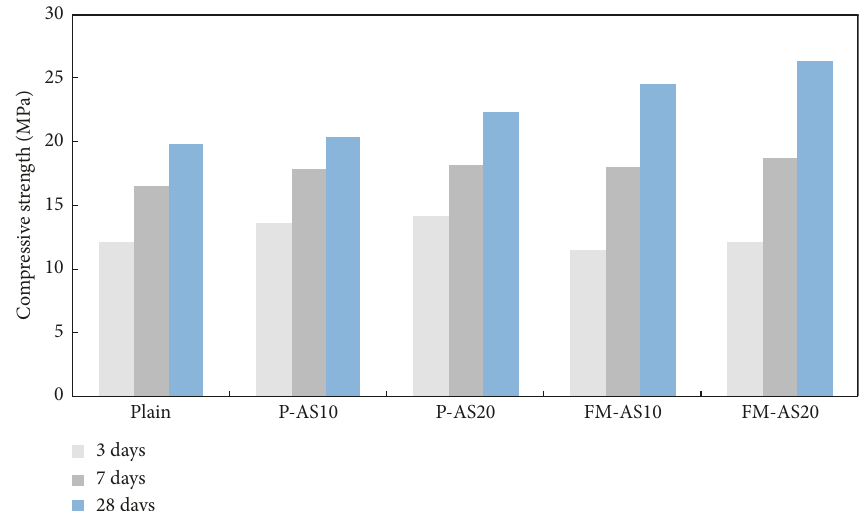
Figure 9: Compressive strength of cement mortar using atomizing slag-modified RMAP.